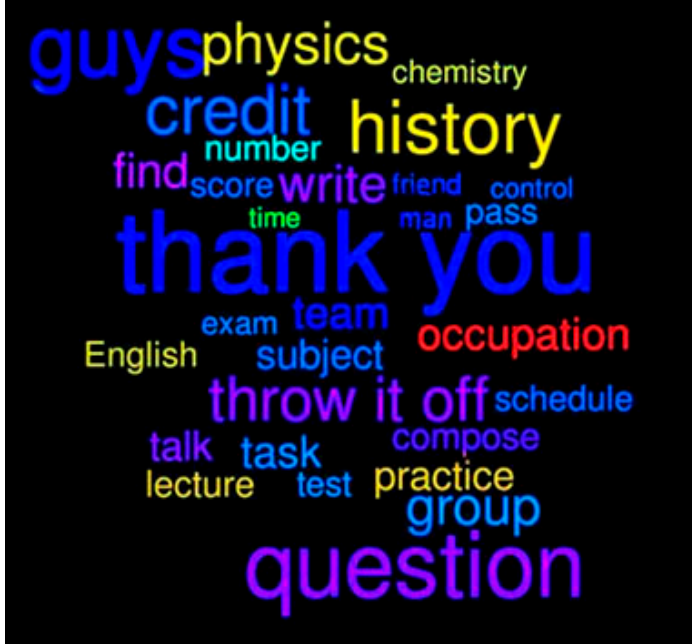
Figure 4. The most common words in student conversations.